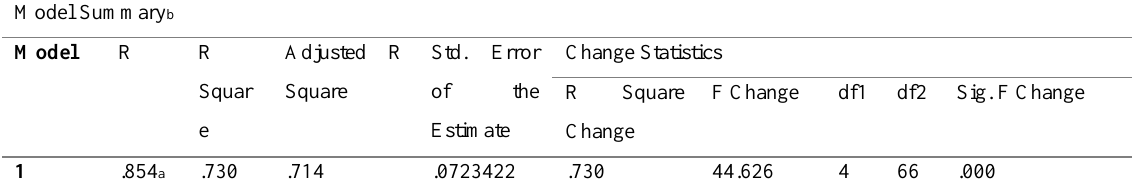
Table 1: Model Summary Relationship between Culture and Strategy